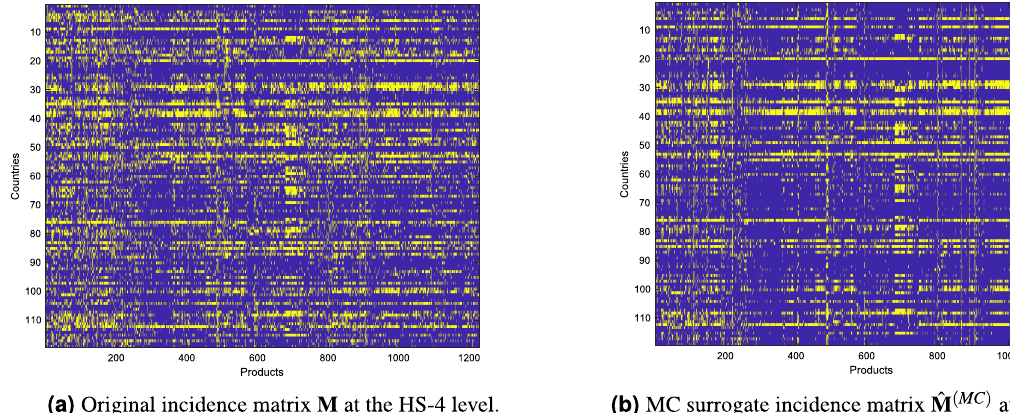
Figure 2. Similarity between the original incidence matrix M and the MC surrogate incidence matrix the year 2018 at the HS-4 level, confirming the good MC prediction performance at a global level.